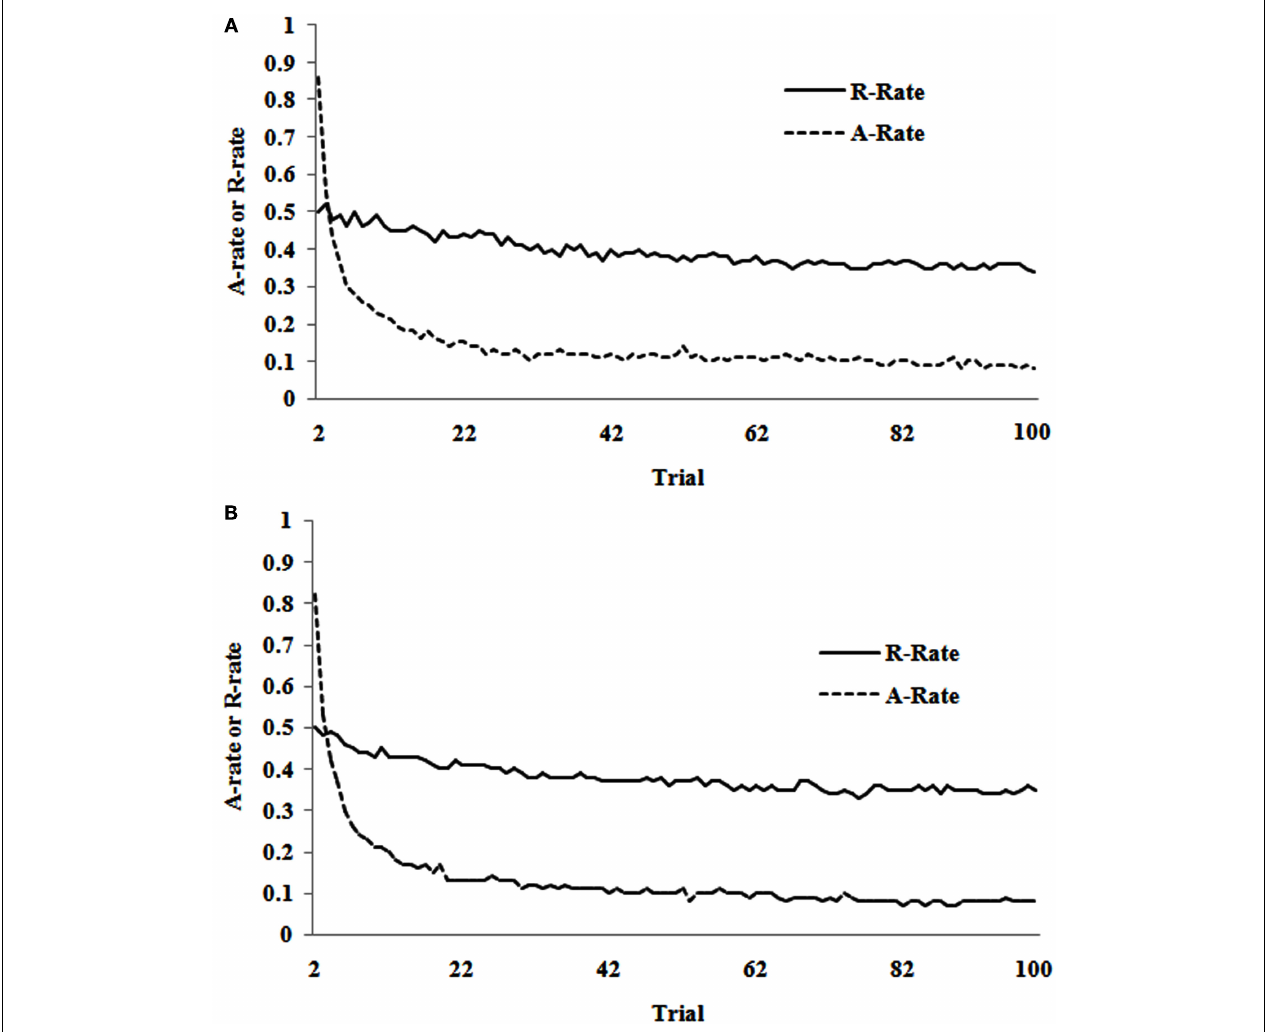
FIGURE 1 | (A) The R-rate and A-rate across trials observed in human data in the estimation set of theTPT between trial 2 and trial 100. (B) The R-rate and A-rate across trials observed in human data in the competition set of theTPT between trial 2 and trial 100.